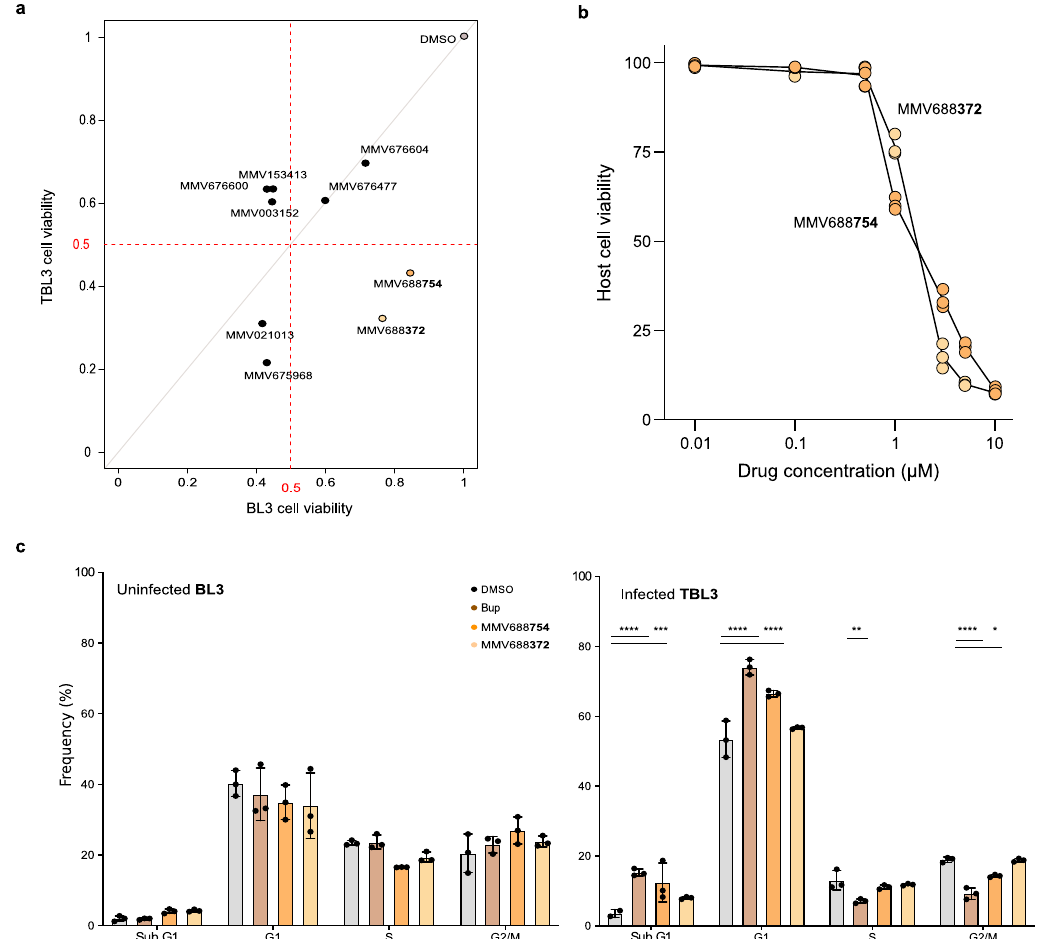
Fig. 3 Comparing the drug impact on infected TBL3 vs uninfected BL3 cells. a Bi-parametric dot plot showing the host cell viability in Theileria -TBL3 and uninfected BL3 cells with a 2 µ M drug-treatment for 48 h. Only two MMV drugs reduced TBL3 survival (<50%), but not BL3 cells (around 80% survival). Representative of three independent experiments. b Cytotoxicity over a range of drug concentrations for TBL3 infected cells. The IC 50 for both drugs MMV688754 and MMV688372 were around 2 µ M. Error bars represent mean values ± SD ( n = 3 replicates). c Cell cycle analysis by fl ow cytometry performed on BL3 and TBL3 cells following treatment with 2 µ M drugs for 48 h. Error bars represent mean values ± SD. n = 3 independent experiments. Two-way Anova statistical test, Dunnett ’ s multiple comparison: * p < 0.05, ** p < 0.01, *** p < 0.001, **** p <